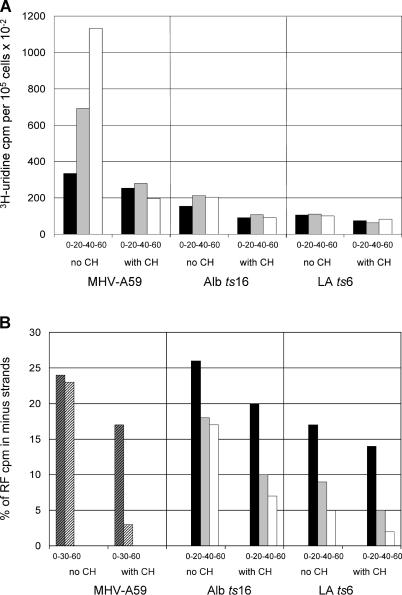
RNA Synthesis Phenotype of the Alb ts16 and LA ts6 MutantsRNA synthesis (A) or negative-strand RNA synthesis (B) was determined using 20 or 30 min pulse labels with 3H-uridine in the presence of dactinomycin, with or without the addition of CH, after shifting the incubation temperature of MHV-A59-, Alb ts16-, and LA ts6-infected cells from 30 °C to 40 °C at 8 hpi: filled bar, 0–20 min pulse; grey bar, 20–40 min pulse; open bar, 40–60 min pulse; dark diagonal bar, 0–30 min pulse; light diagonal bar, 30–60 min pulse.